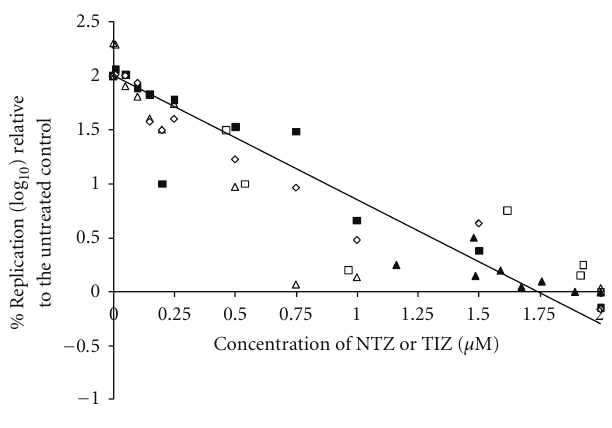
Figure 2: E ff ect of NTZ (closed) or TIZ (open) against CIV (Ca/CO-1 ( (cid:2) , Δ ) Ca/CO-3 ( (cid:3) , (cid:4) ) and Ca/CO-4 ( (cid:5) , ♦ )) relative to the replication of the untreated controls in MDCK